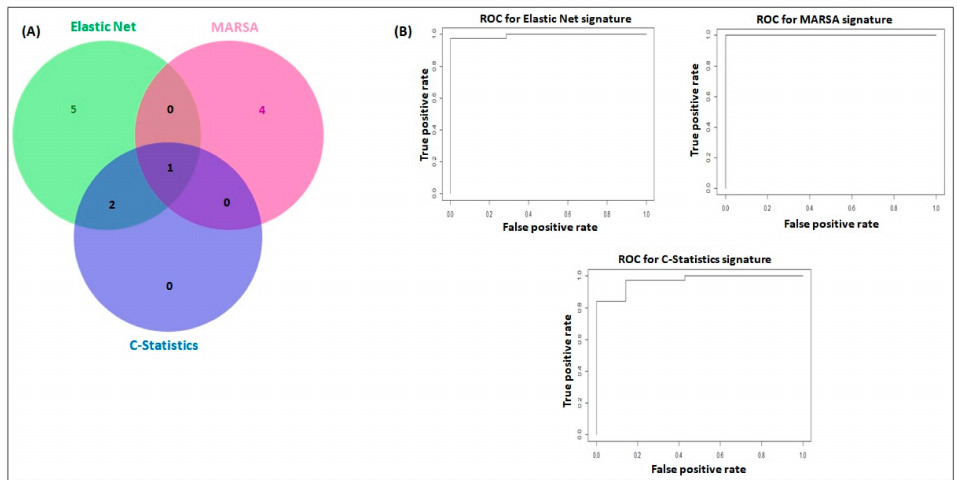
Figure 2. Plasma miRNA signatures. Panel ( A ) is the Venn diagram showing the identified signatures by Elastic net (eight miRNAs: miR-16-5p, miR-92a, miR-451a, miR-106b-5p, miR-155-5p, miR-217, miR-1285-3p, miR-1285-5p), MARSA (five miRNAs: miR-16-5p, miR-148b-3p, miR-378e, miR-484, miR-664a-3p), and C-Statistics (three miRNAs: miR-16-5p, miR-92a, miR-451a). The miRNAs miR-16-5p, miR-92a, and miR-451a were shared among Elastic net and C-Statistics signatures. miR-16-5p was the only miRNA shared by all signatures. Panel ( B ) shows the ROC, Sensitivity and Specificity data for identified miRNA signatures: Elastic net, MARSA, and C-Statistics.